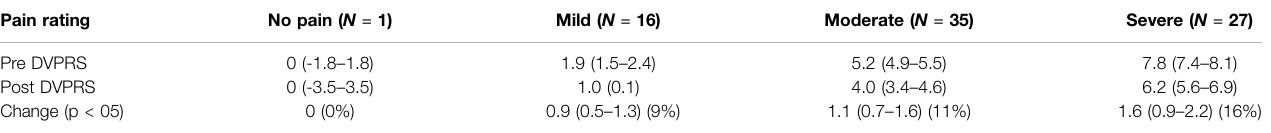
TABLE 7 | Effect of Pre-VR pain category on pre and post VR session pain rating (DVPRS 0 – 10). Pain